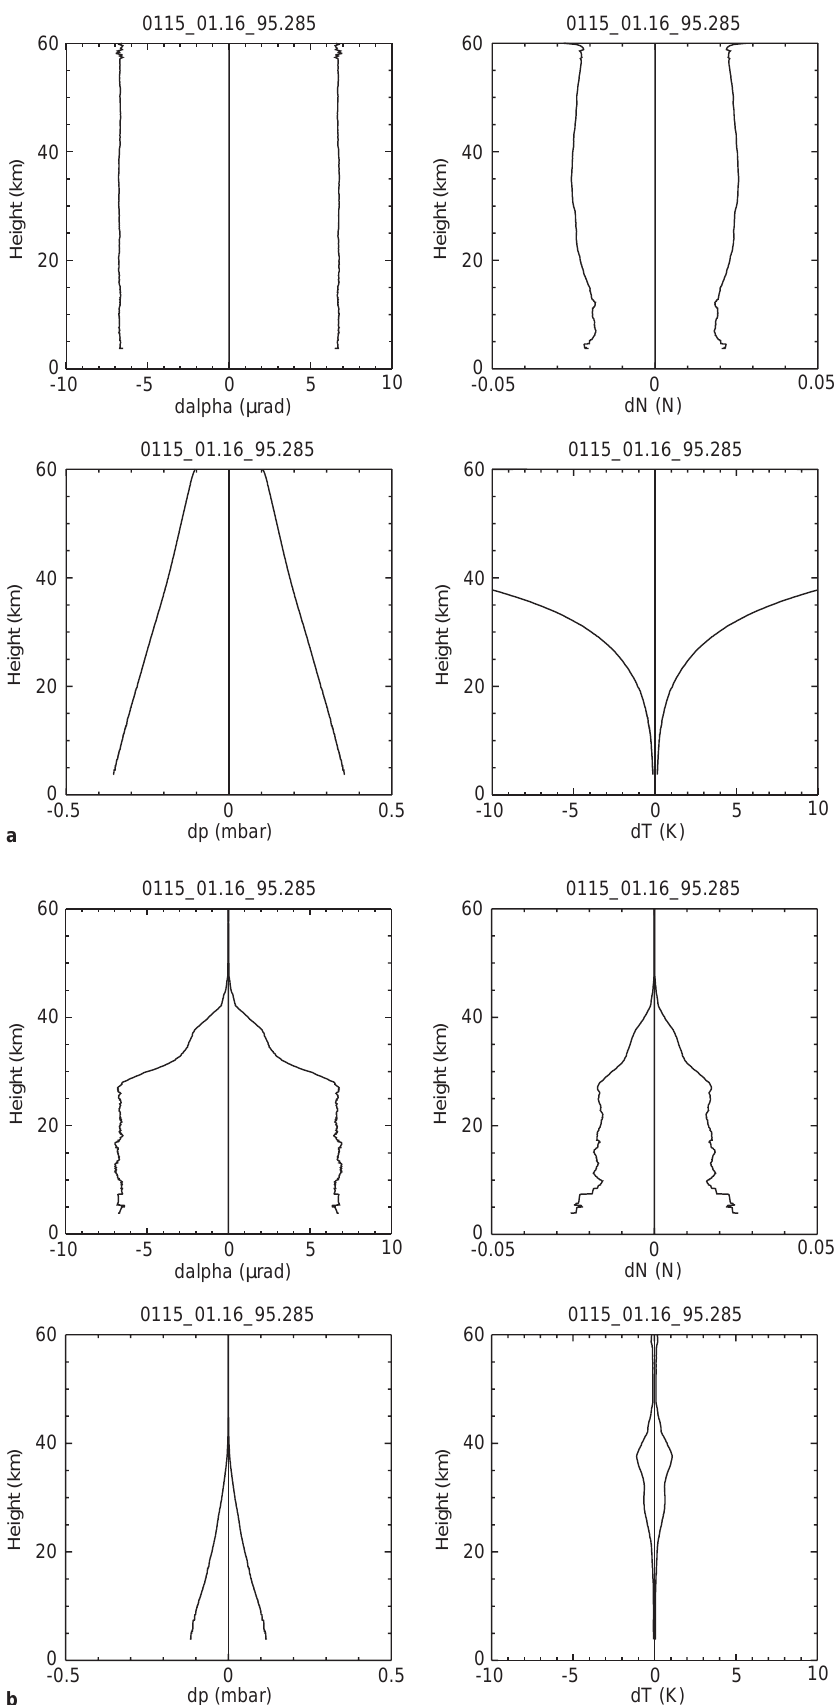
Fig. 7a, b. Results of error estimation analysis taking into account statistical bending angle error ( upper left panel ) only. The resulting statistical errors in refractiv- ity ( upper right panel ), pressure ( bottom left panel ), and temperature ( bottom right pan- el ) are shown. a Shows the errors incurred if the 50 Hz bending angle data are weakly filtered only. More appropriate filtering of the bending angle data between 30 km and 70 km height plus upper-boundary initial- ization by perfect a priori data reduces the statistical error as shown in b. The GPS/ MET data used are the same as in